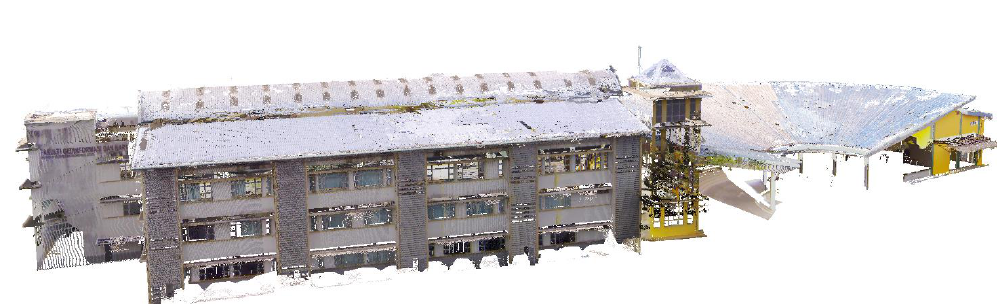
Figure 16 Merged point clouds from UAV and TLS